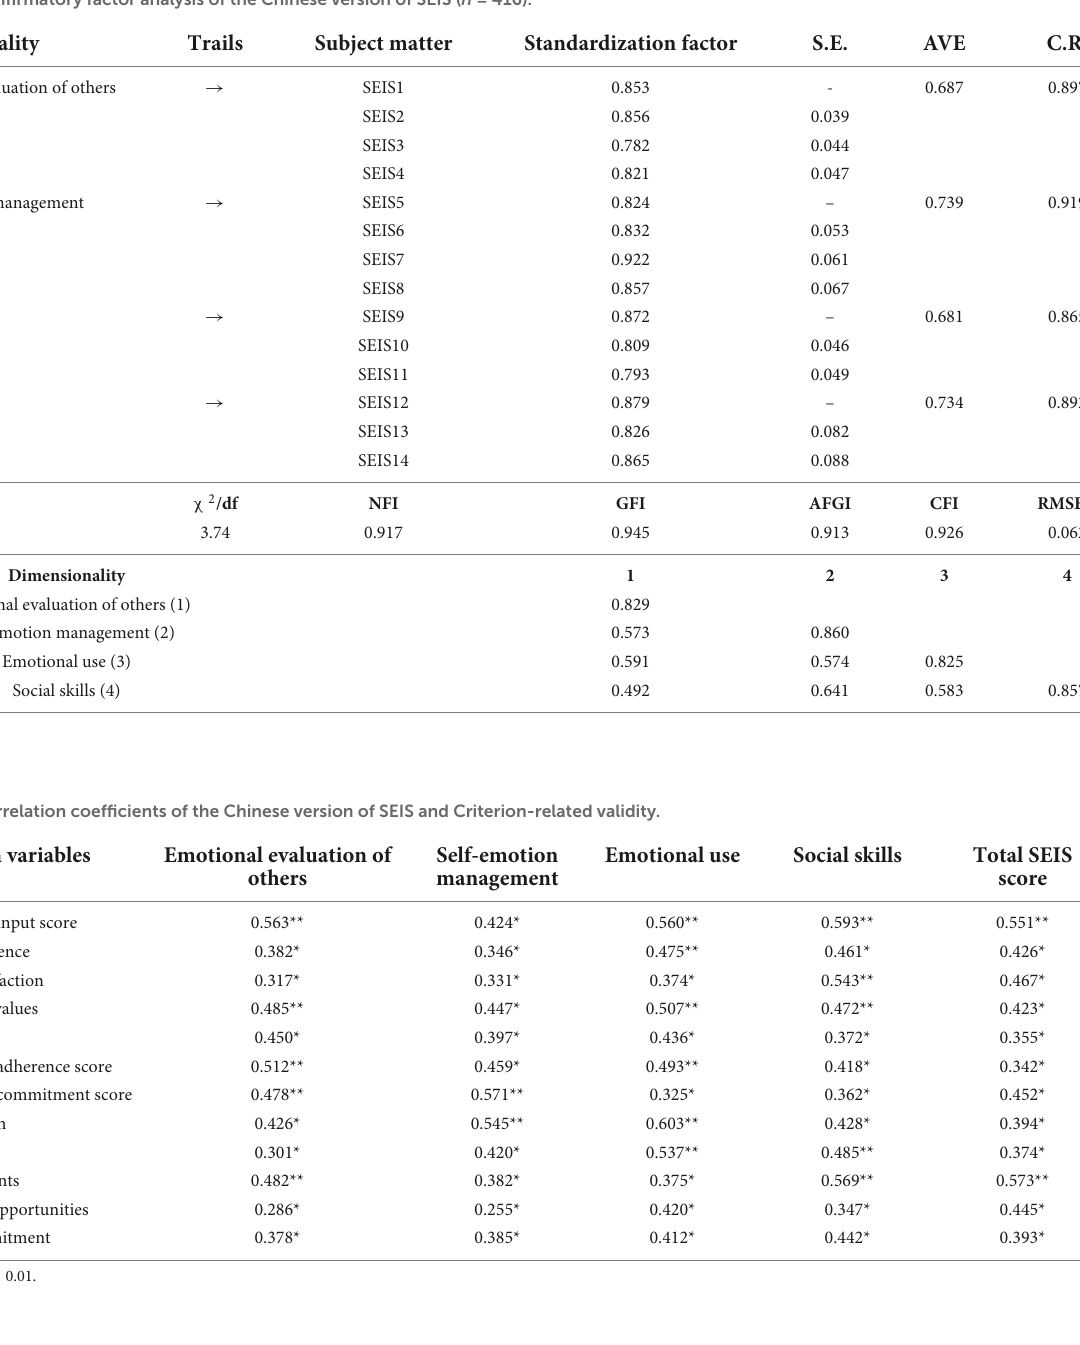
TABLE 3 Confirmatory factor analysis of the Chinese version of SEIS ( n = 416).